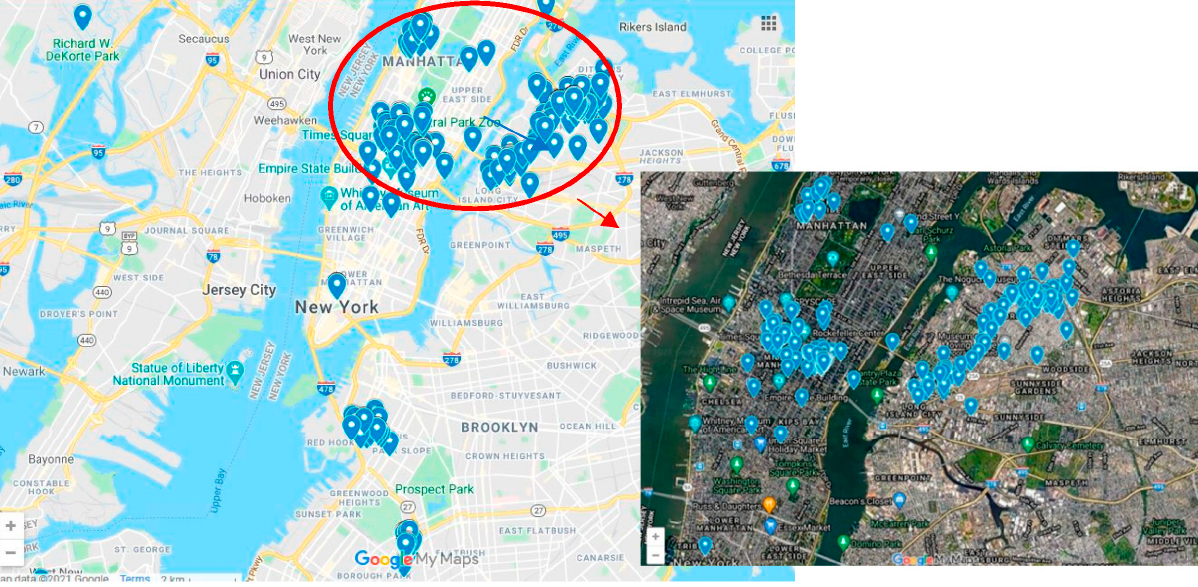
proposed EAGRU architecture’s hidden layers h τ and latent factors d (d = 10) were set. As